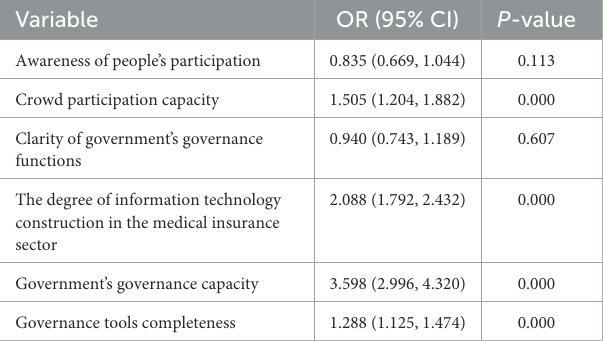
TABLE 4 Classification results according to the explaining variable of the original data—logistic regression analysis ( n = 1,975). Variable OR (95% CI) P